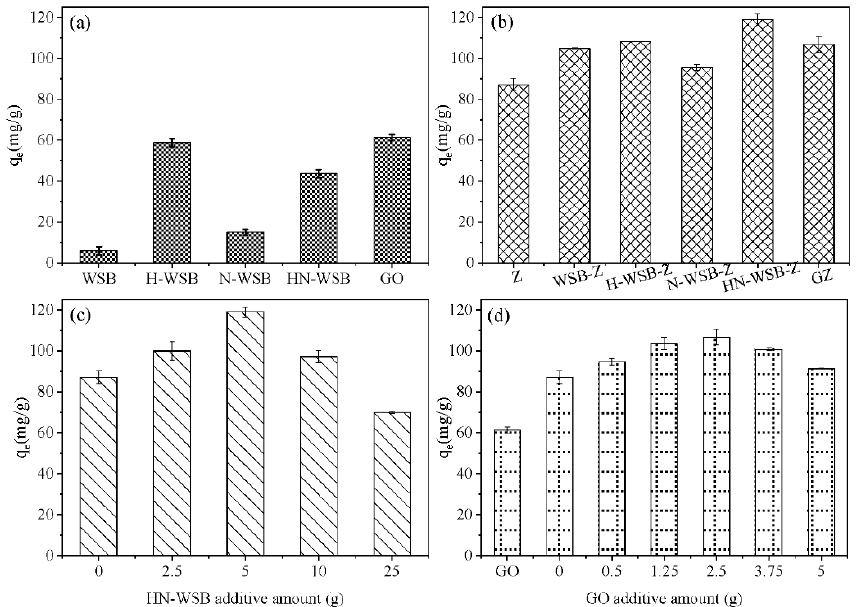
Figure 5. Cu(II) adsorption capacities of biochar and GO ( a ), Z and composite FAUs ( b ), composite FAUs with different additive amount of HN-WSB ( c ) and GO ( d ) (conditions: T = 298 K, t = 180 min, C 0 = 20 mg/L, dosage = 0.2 g/L).